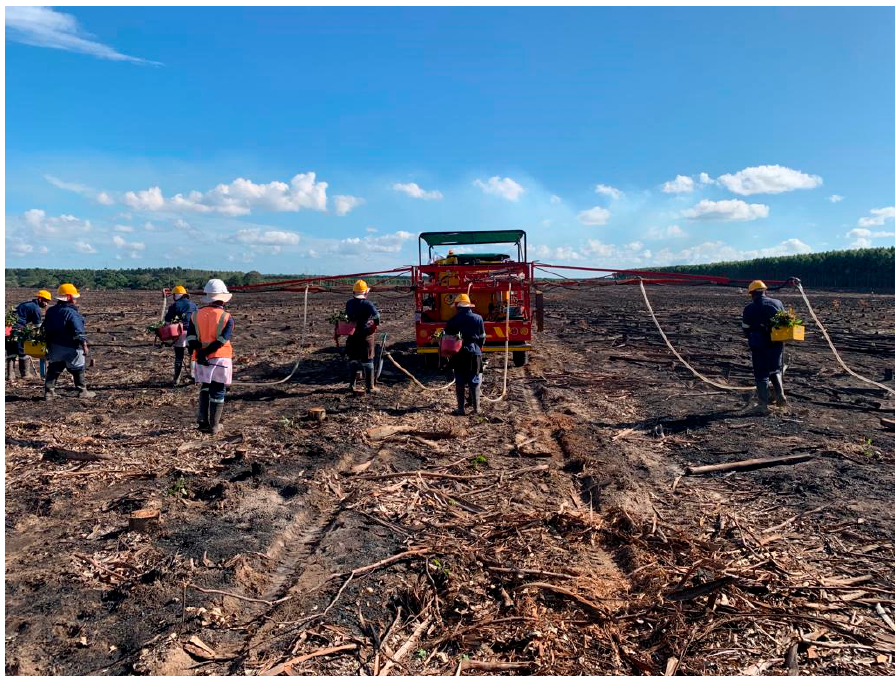
Figure 17. In some areas in KwaZulu-Natal, container-grown seedlings are planted during the rainy season (summer). Sometimes 1 to 5 L of water is applied in the planting hole before inserting a seedling. “The use of and/or method of application of the water varies widely between regions and commercial forestry companies. Some companies have a ‘no water’ policy, others always plant with water, while some only apply water when planting conditions are considered poor (hot weather, dry conditions)” [10]. Applying 2 L of water to young, 7-cm tall, container-grown patula pine seedlings increased survival by 12% at one location but decreased survival of 14-cm tall seedlings by 6%